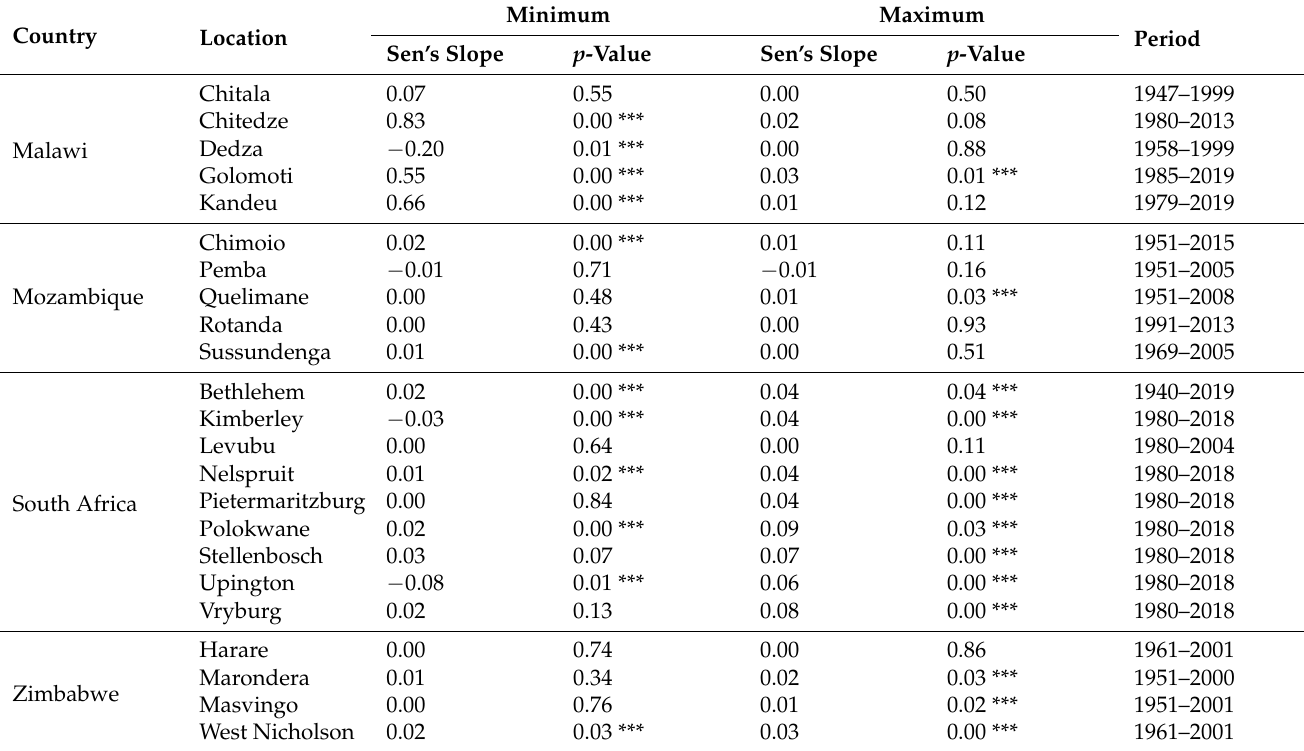
Table 4. Sen slope of minimum and maximum temperature trends at meteorological stations in each